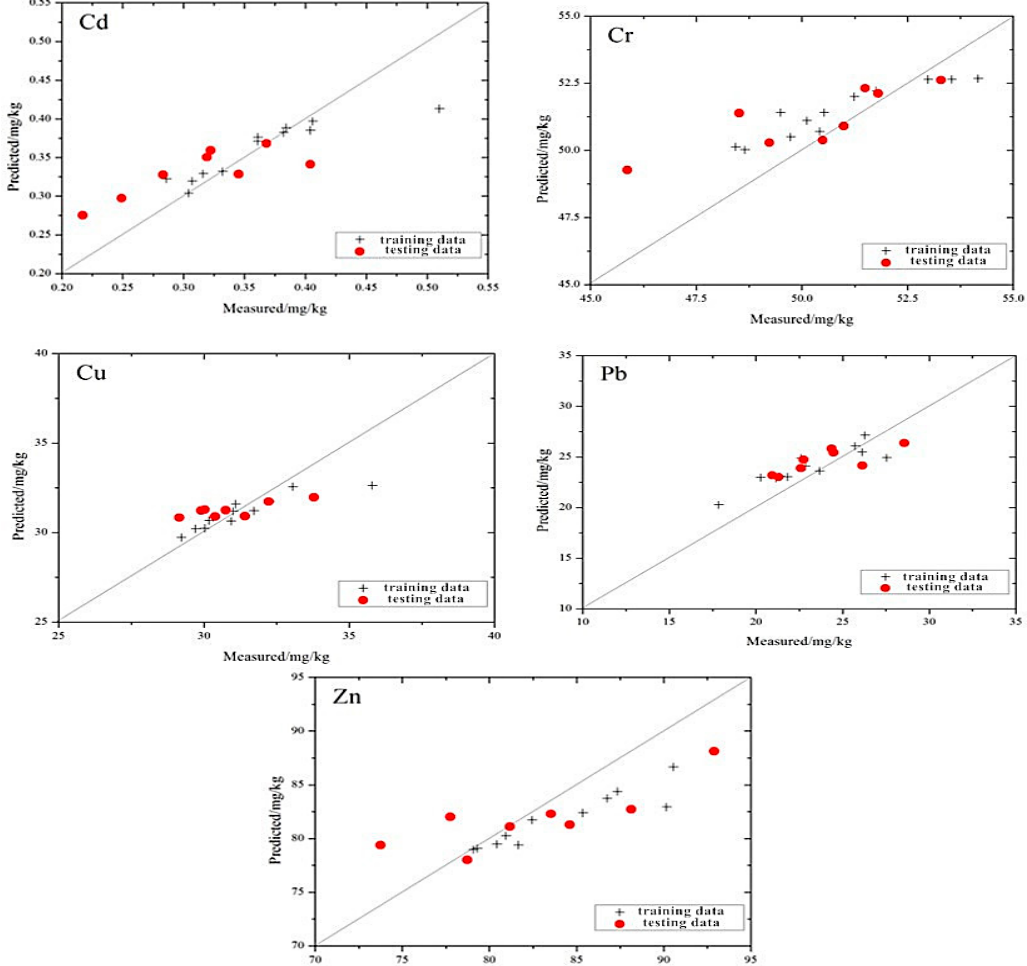
Figure 5. Individual points of heavy metal concentrations of the mine reclamation soils predicted by the GRNN model plotted against the measured values.